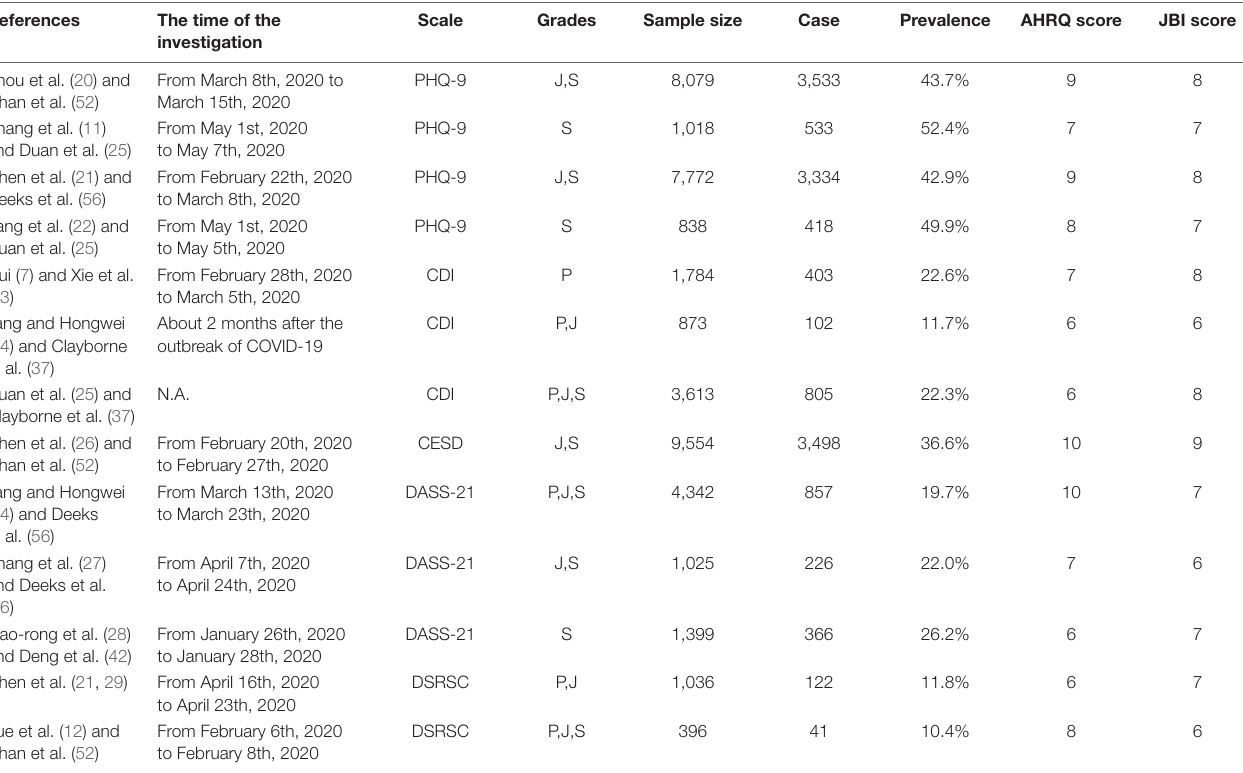
TABLE 1 | Characteristics of the 13 studies of depressive symptoms in the